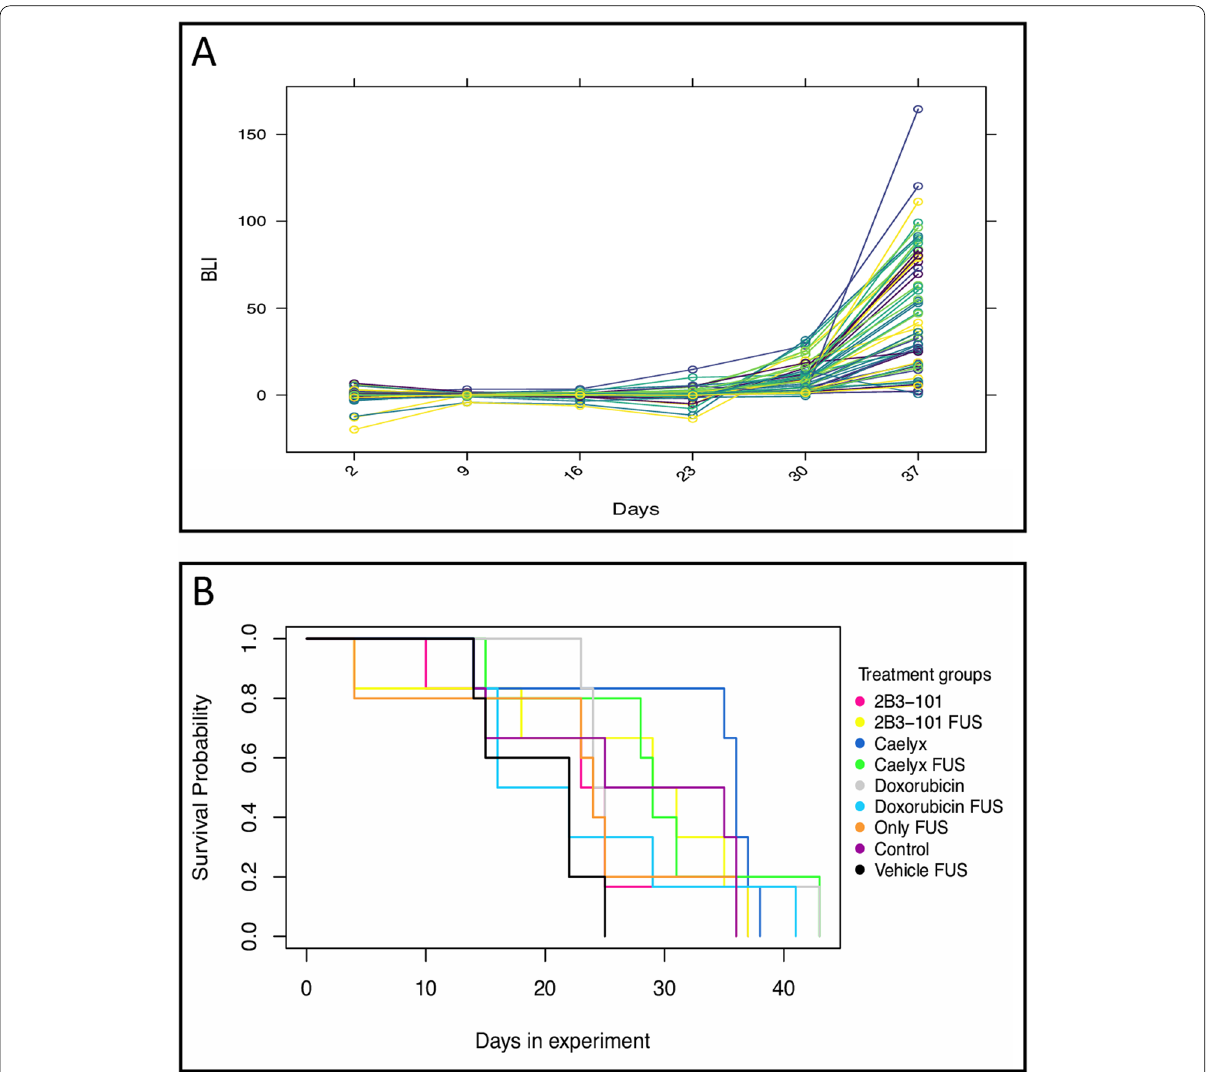
Fig. 4 BLI monitored tumor engraftment and survival following treatment. A Weekly BLI (photon/sec/m2) monitoring as a measure of tumor engraftment. The mean intensity of the background was subtracted from the tumor BLI. Exponential growth was observed 37 days after tumor implantation. B Survival analysis (Kaplan–Meier curve) of the different treatment groups. Day 0 is the start of treatment. “Days in experiment” represents the number of days after treatment. Differences in groups ( n 6 mice per group) were not statistically significant ( p = =